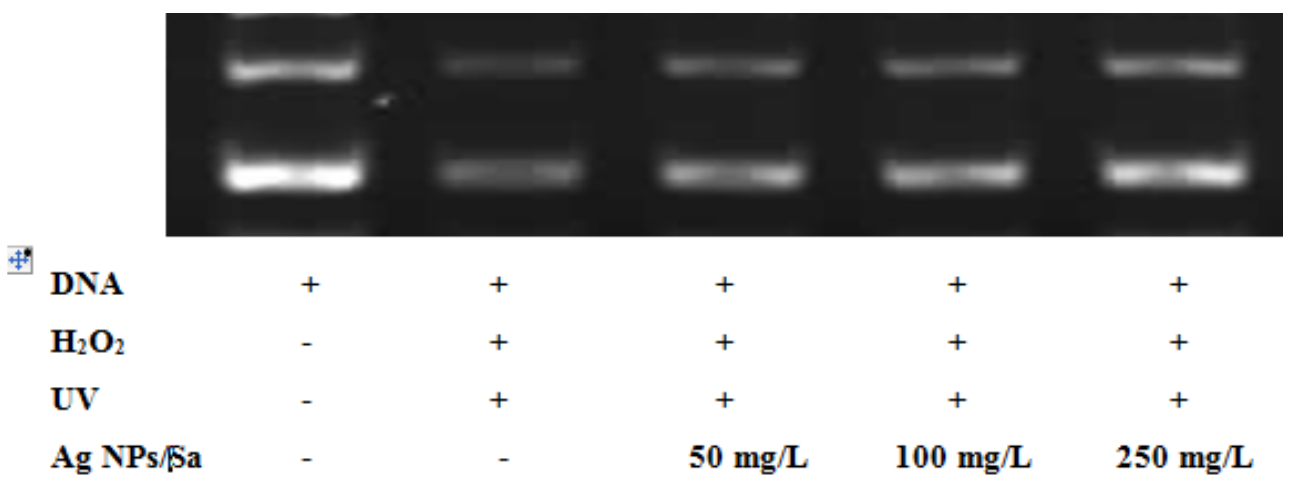
FIGURE 6 - Gel electrophoresis image of Ag NPs/Sa samples and substances added to the